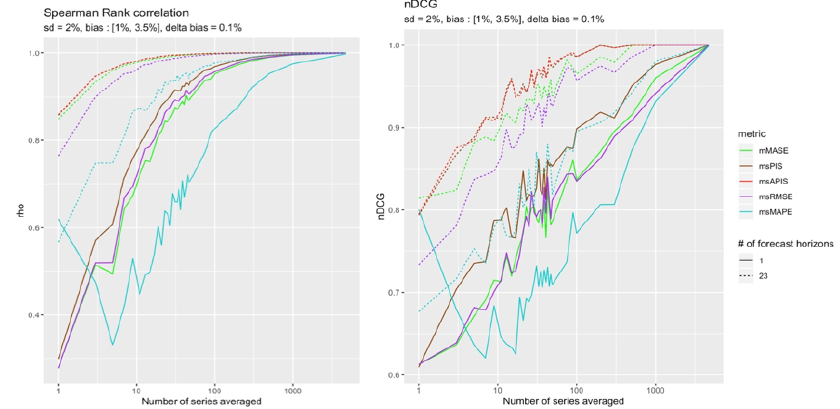
Figure 15. Spearman Rank correlation and nDCG for ( + + + ) configuration.